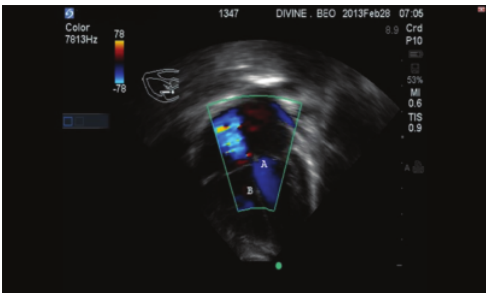
Figure 2: Color flow Doppler showing the tricuspid leaflet with no tricuspid regurgitation. (A) indicates LV. (B) shows the RV.